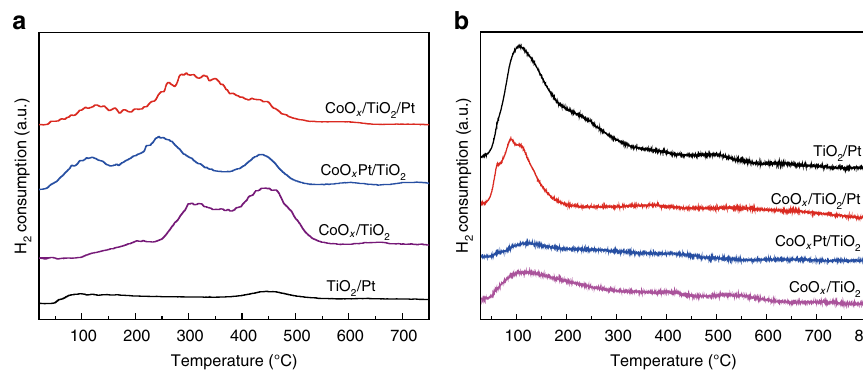
Fig. 4 Chemisorption characterizations. a H 2 -TPR and b H 2 -TPD pro fi les of